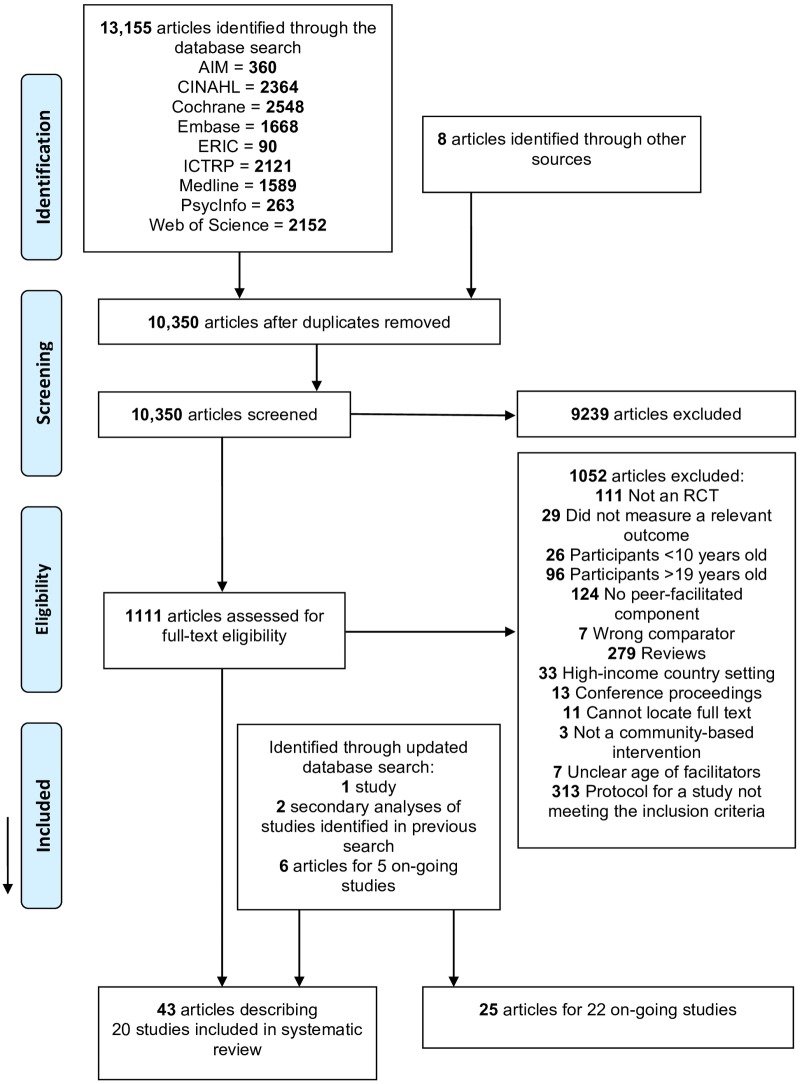
PRISMA 2009 Flow Diagram.From: Moher D, Liberati A, Tetzlaff J, Altman DG, The PRISMA Group (2009). Preferred Reporting Items for Systematic Reviews and Meta-Analyses: The PRISMA Statement. PLoS Med 6(7): e1000097. doi: 10.1371/journal.pmed1000097
For more information, visit
www.prisma-statement.org.